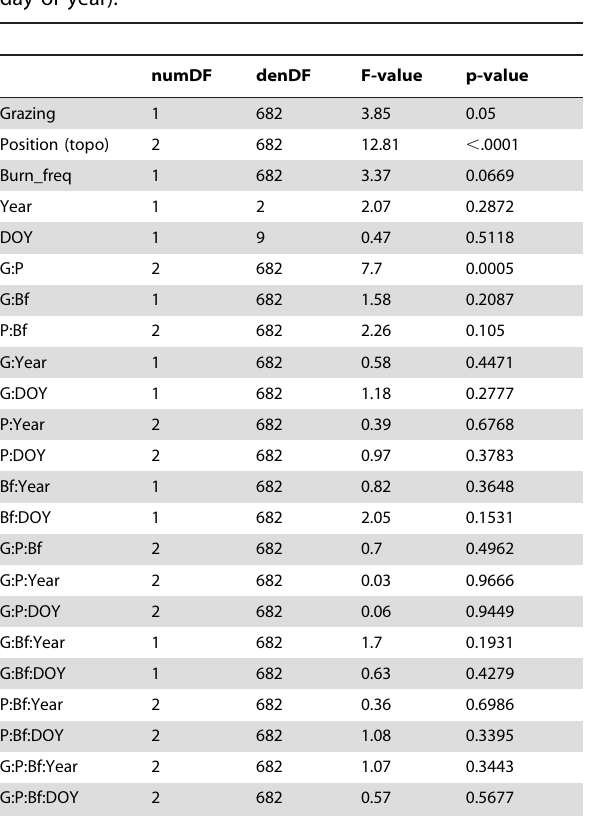
Table 2. Mixed-effects model results for leaf d 13 C ( % ) among landscape contrasts including: grazing (grazed/ungrazed), topographic position (upland, slope, lowland), and burn frequency (1, 2, 4, 10, 20) and temporal contrasts (year and day of